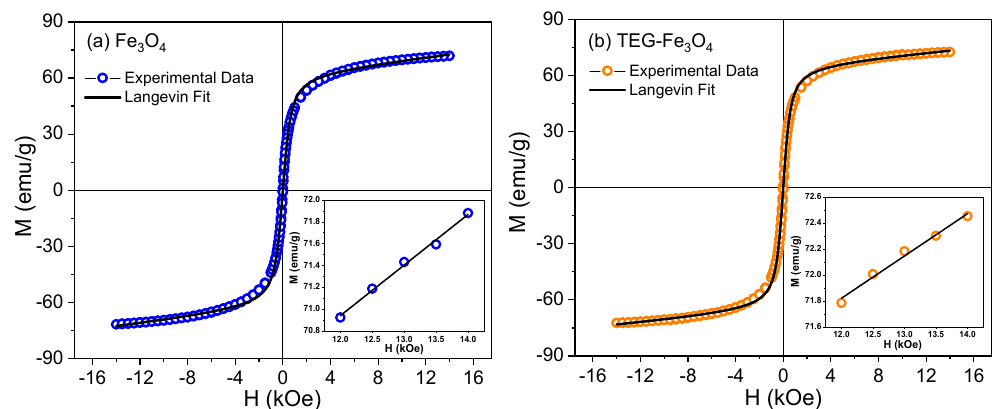
Fig. 6. Magnetic hysteresis loops of (a) Fe the fit result with the modified Langevin function. The inset shows linear fit results of high fields’